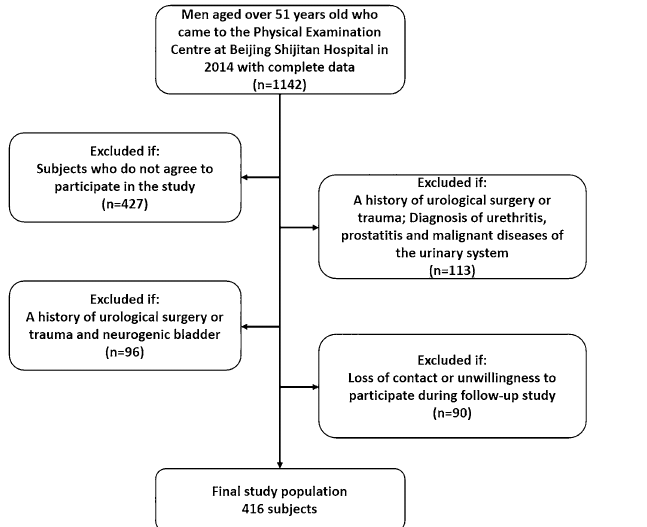
Figure 1. Flow chart of selection of the included